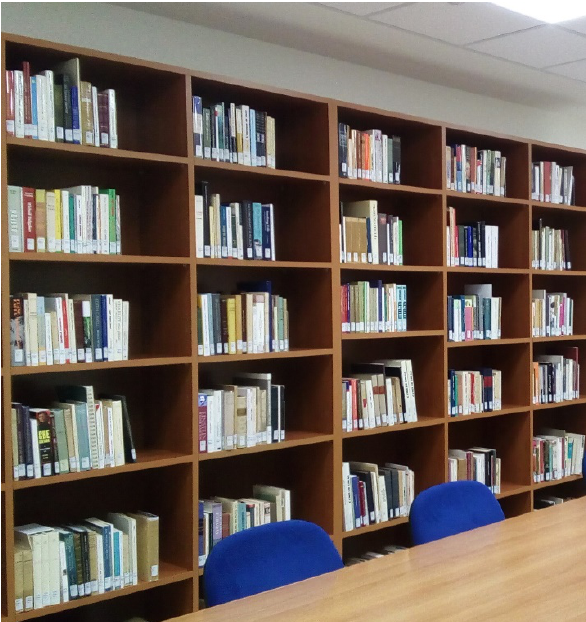
Figure 2 Part of the Biographies Room. Photo credit: